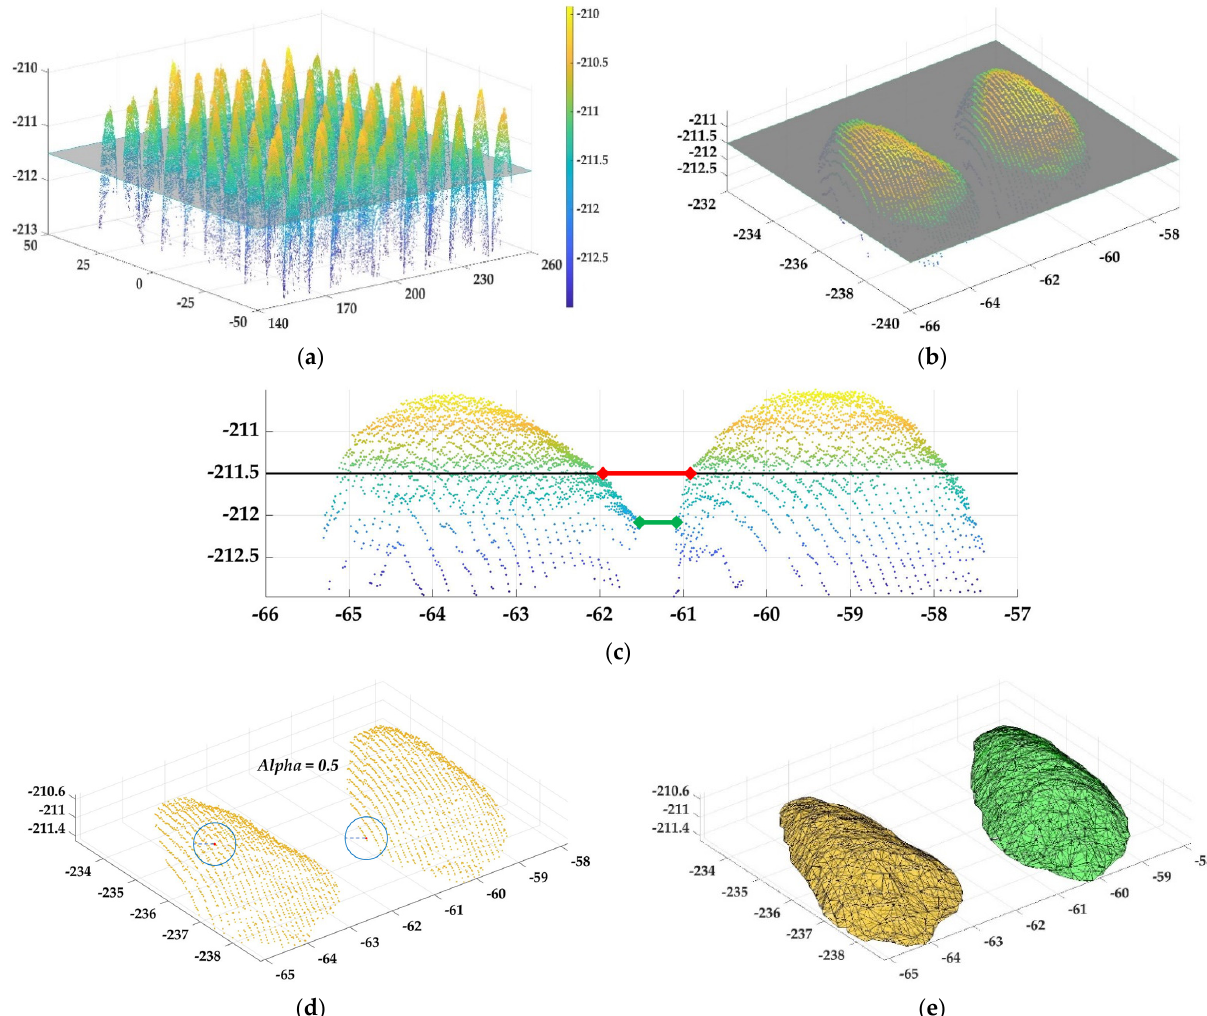
Figure 6. Single-rain point-cloud extraction. ( a ) All grain point clouds with segmented plane; ( b ) two grains’ point clouds and segmentation plane; ( c ) analysis of two grains’ point clouds and segmentation planes. The red line and green line indicate the distance between grains at different height levels.; ( d ) the upper part of the grain point cloud; ( e ) classification result of the upper part of different